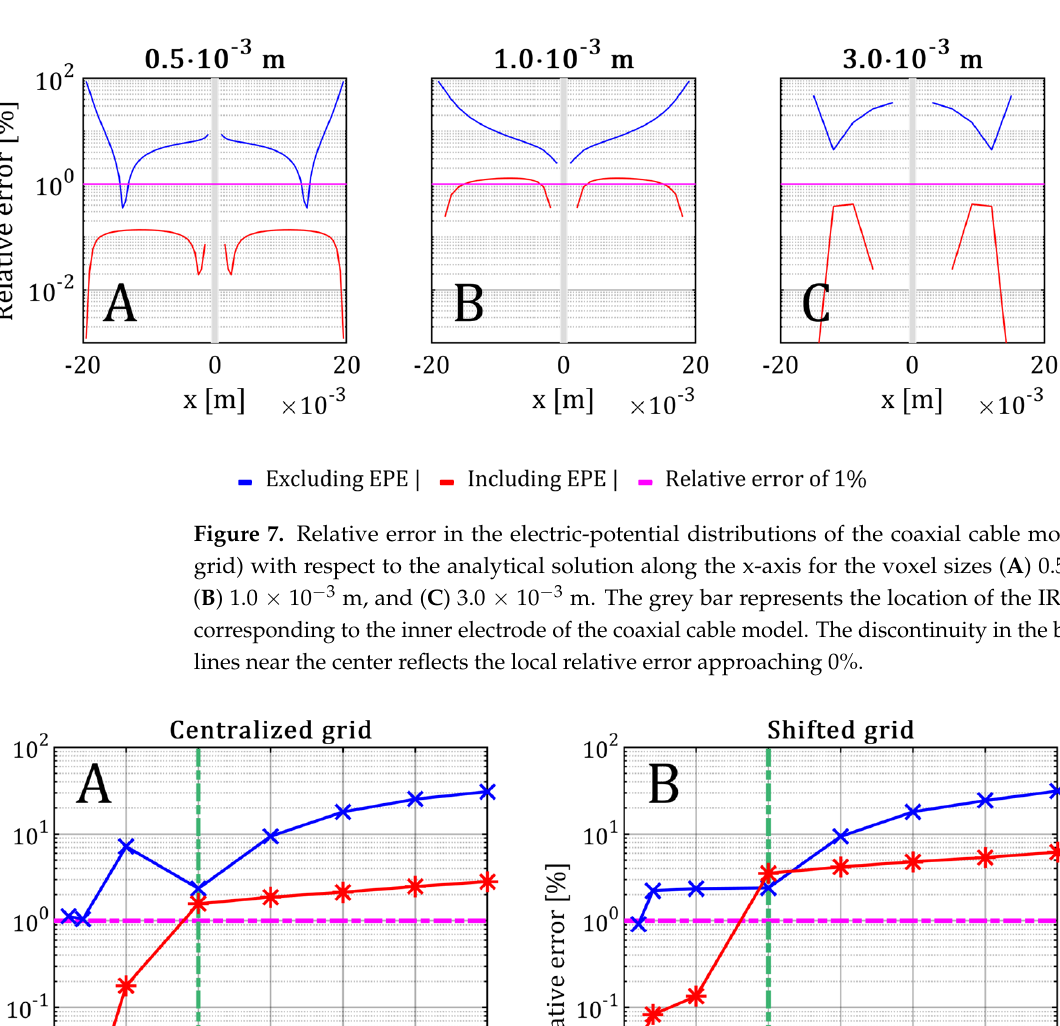
Figure 7. Relative error in the electric-potential distributions of the coaxial cable model (central grid) with respect to the analytical solution along the x-axis for the voxel sizes ( A ) 0.5 × 10 − 3 m, ( B ) 1.0 × 10 − 3 m, and ( C ) 3.0 × 10 − 3 m. The grey bar represents the location of the IRE electrode, corresponding to the inner electrode of the coaxial cable model. The discontinuity in the blue and red lines near the center reflects the local relative error approaching 0%.